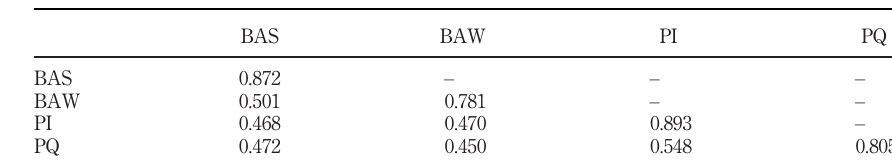
Table 3. Discriminant validity of latent